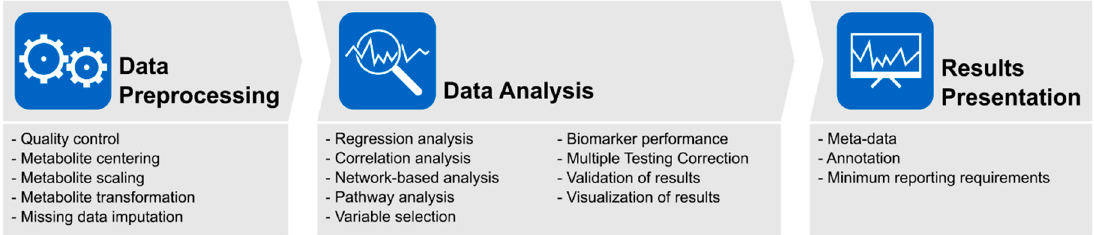
Figure 9. Suggested metabolomics analysis workflow.